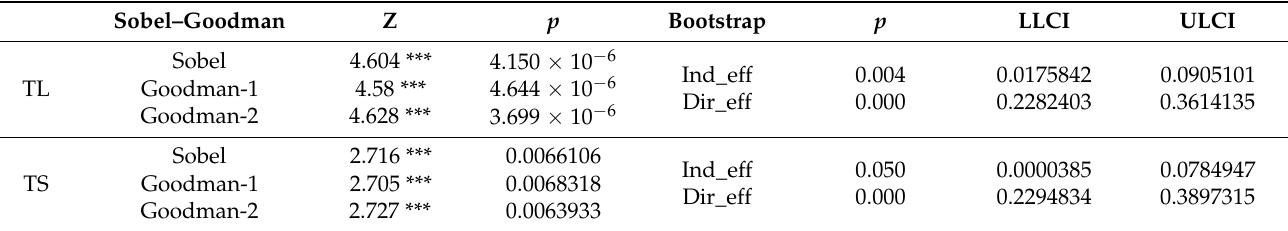
Table 6. Sobel–Goodman and Bootstrap tests.